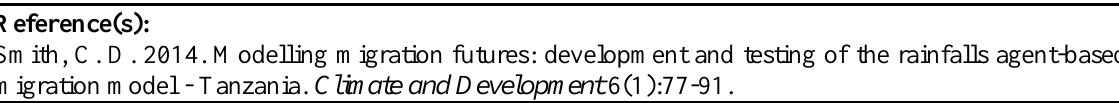
Table A1.13 Standardized protocol for the ABM described by Smith (2014)